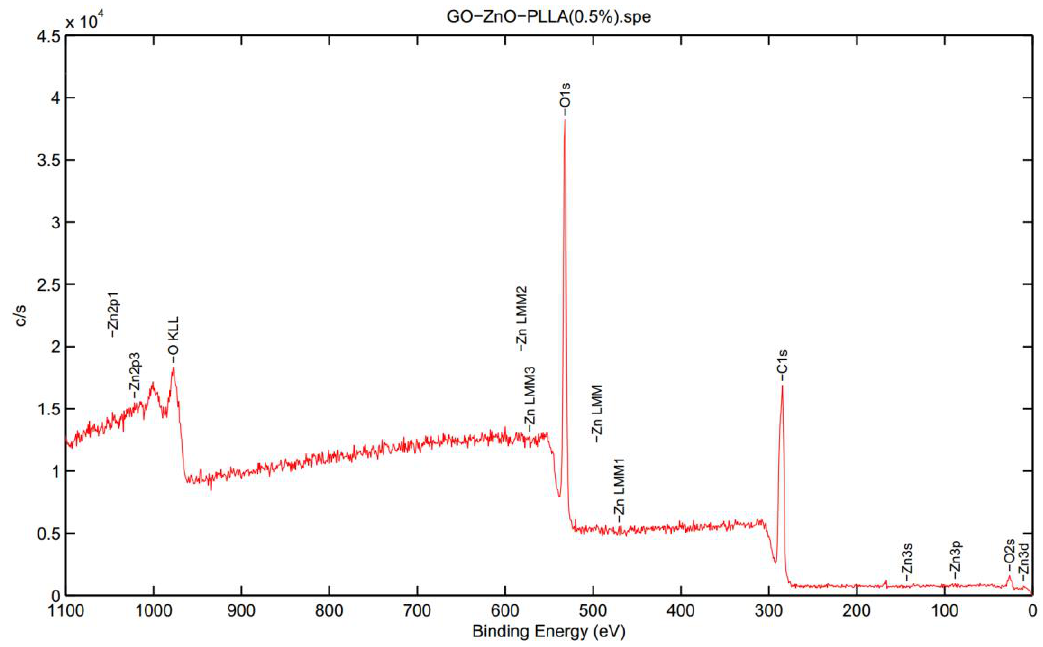
Figure 4. XPS (X-ray Photoelectron Spectroscopy) survey spectrum of GO-ZnO-PLLA.